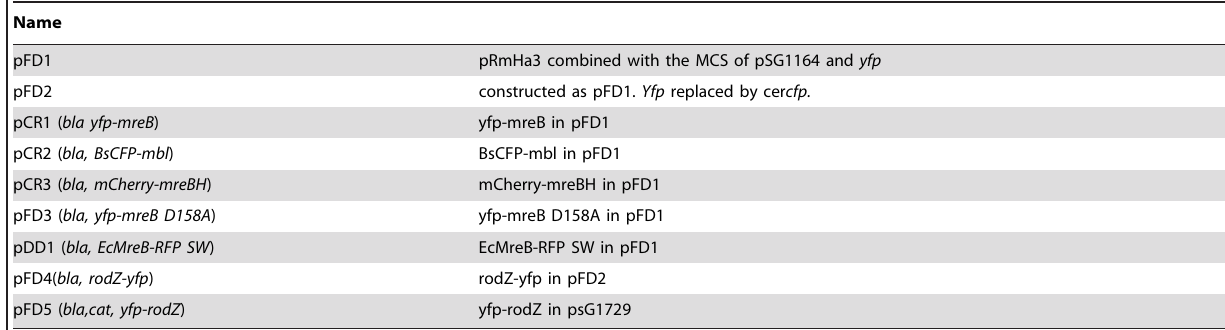
Table 3. Generated